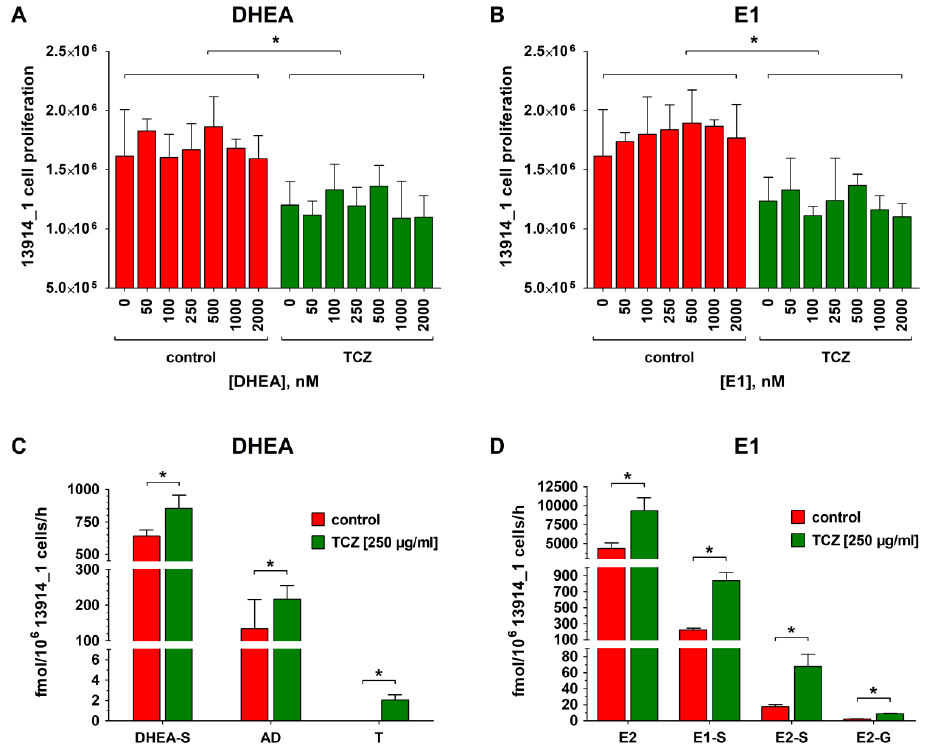
Figure 5. Effect of tocilizumab (TCZ) treatment on the proliferation and steroid metabolism of 13914_1 cell line. Platinum-resistant 13914_1 cells, demonstrating a high endogenous IL-6 formation (302.6 pg/10 6 cells/h), were incubated with TCZ (250 µg/mL) for 72 h, followed by incubation with TCZ in the presence of increasing concentrations (0 to 2000 nM) of ( A ) DHEA and ( B ) E1 for 48 h and the viable cells were counted on a CASY ® TT cell counter. Subsequently, the cellular supernatants of the samples containing 2000 nM of the steroid precursor ( C ) DHEA or ( D ) E1 were analyzed for steroid metabolites using LC-HRMS. Green indicates sensitivity for carboplatin and red represents carboplatin resistance. All data are presented as the means ± SD of three independent experiments. * p < 0.05.